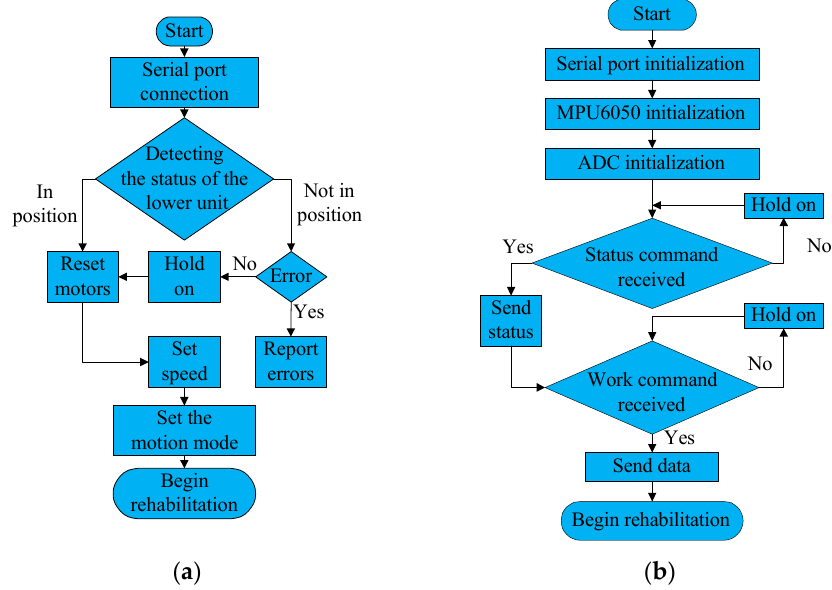
Figure 11. Program Flowchart of ( a ) upper and ( b ) lower computer.